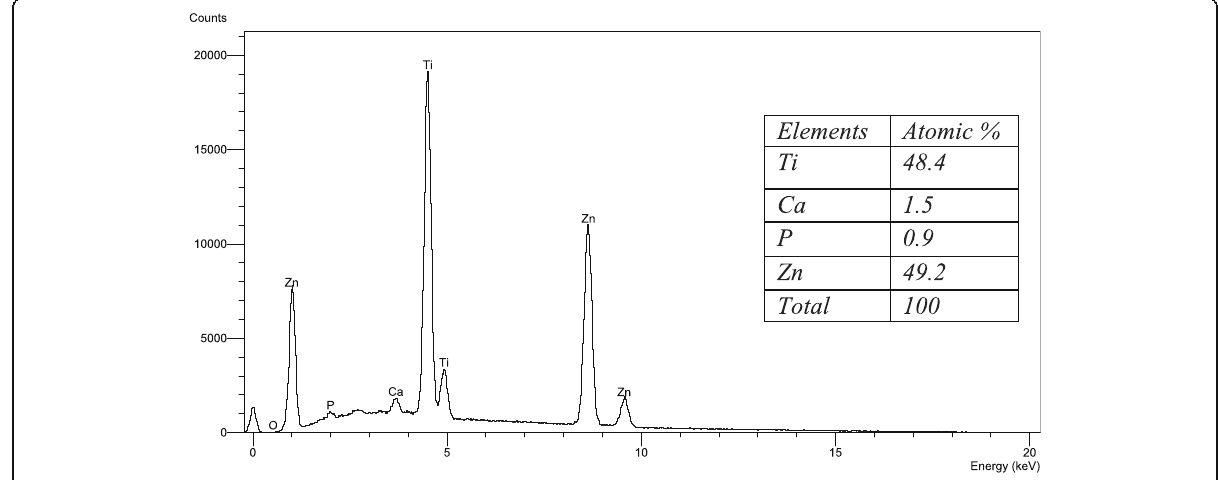
Fig. 10 Energy dispersive spectrum of Cp titanium specimen coated with HA-Zn